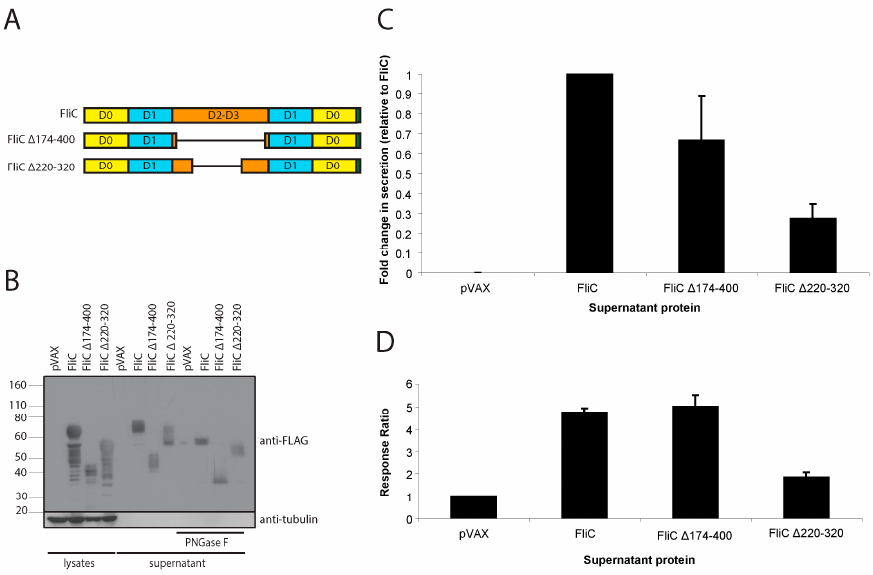
Figure 2. FliC constructs expressed in a mammalian system are secreted and maintain Toll-like receptor 5 (TLR5) agonist activity. ( A ) Schematic representation of flagellin (FliC) constructs; ( B ) Western blot of cell lysates, supernatants and PNGase F treated supernatants from transiently transfected 293T. Cells were transfected with pVAX (empty vector), FliC, FliC Δ 174–400 or FliC Δ 220–320. Samples were collected 48 h post transfection. Blots were probed with a mouse anti-FLAG tag antibody to detect FLAG-tagged flagellin proteins. A mouse anti-tubulin antibody, was used to detect tubulin as a loading control; ( C ) Measurement of relative secretion level of FLAG-tagged proteins using capture ELISA. Supernatants from transiently transfected 293T were applied to anti-FLAG tag antibody coated plates and probed with a horseradish peroxidase (HRP) conjugated mouse anti-FLAG tag antibody. Results shown represent the mean of 4 different experiments where FliC is set to a value of 1. Error bars represent standard error of the mean; ( D ) Relative TLR5 agonist activity of secreted FliC proteins. Normalized supernatants from transiently transfected 293T were diluted 1:100 and added to HEK-Blue-hTLR5 cells. After 20 h incubation, the quantity of secreted embryonic alkaline phosphatase (SEAP) produced was determined using a colorimetric enzyme assay. Relative quantities, presented as response ratios, are indicative of TLR5 agonist activity. Results shown represent the mean of 4